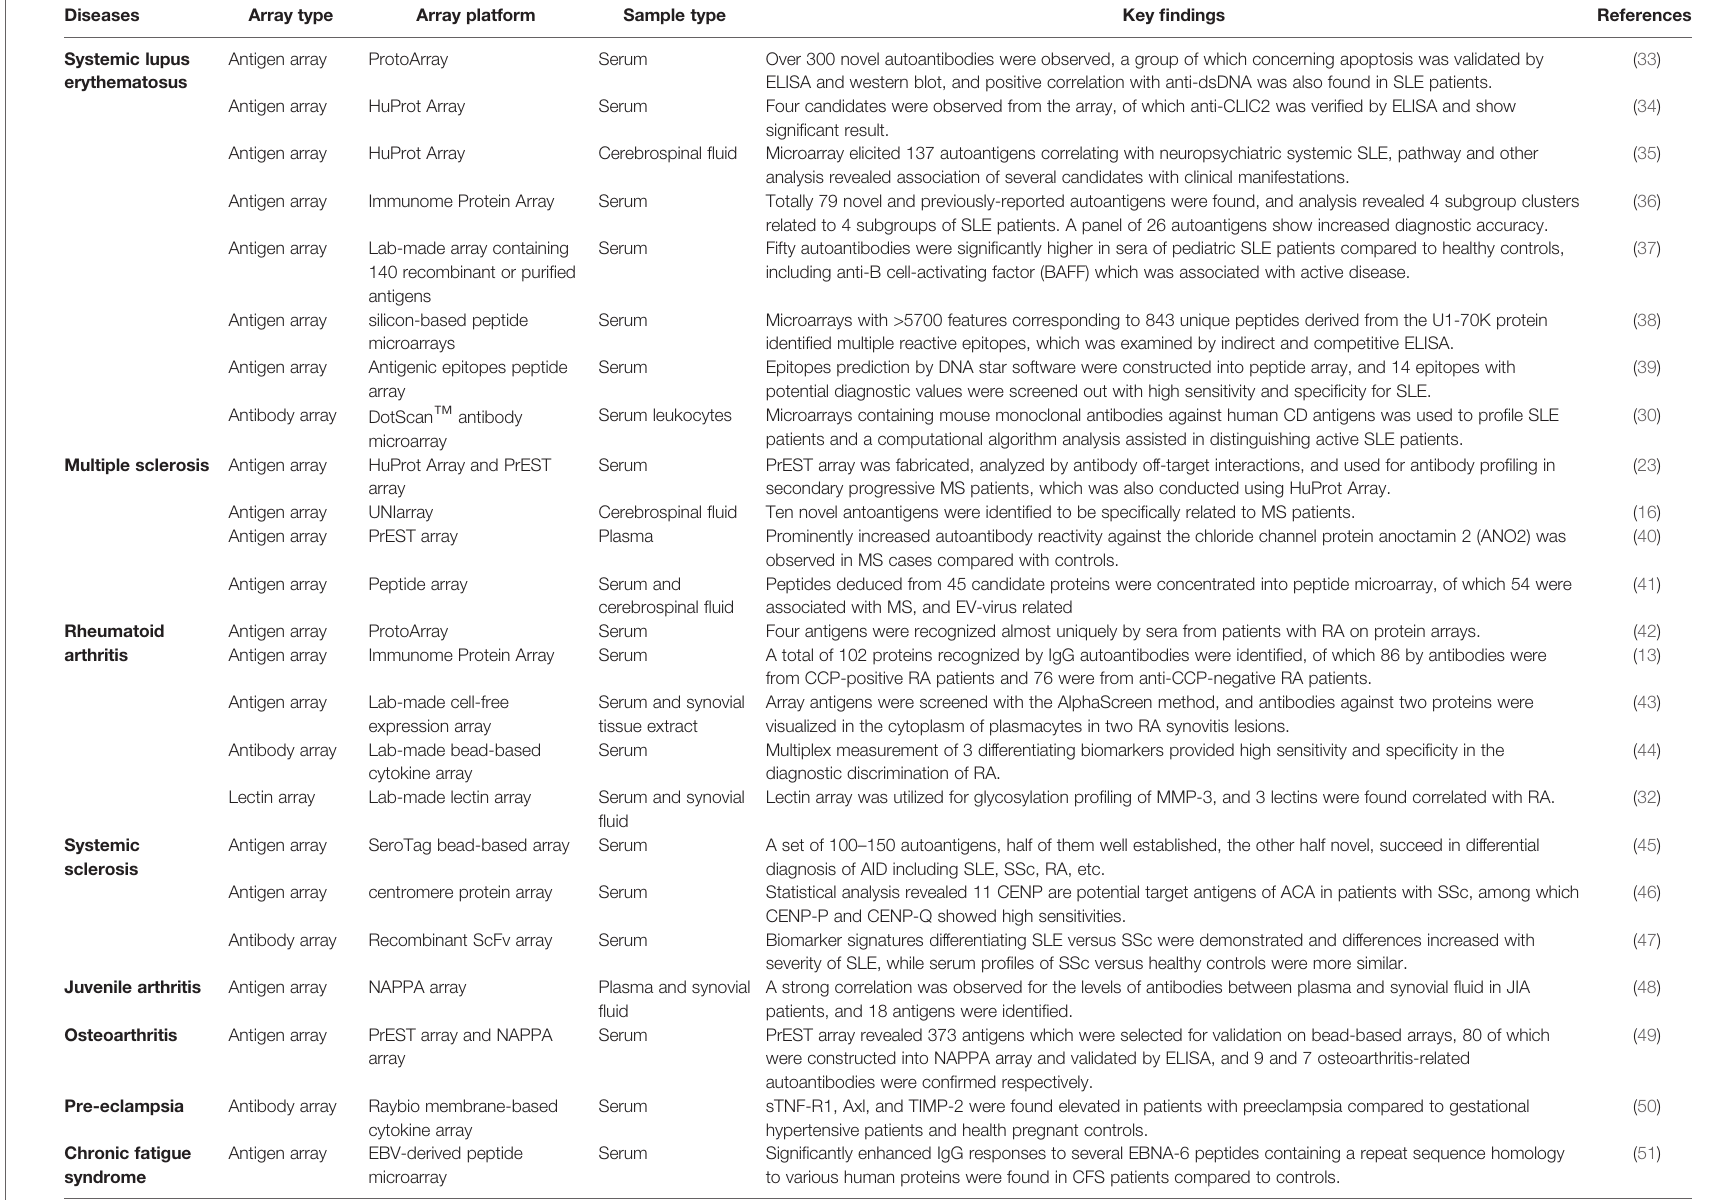
TABLE 2 | Selective application of protein microarrays in biomarker discovery for autoimmune